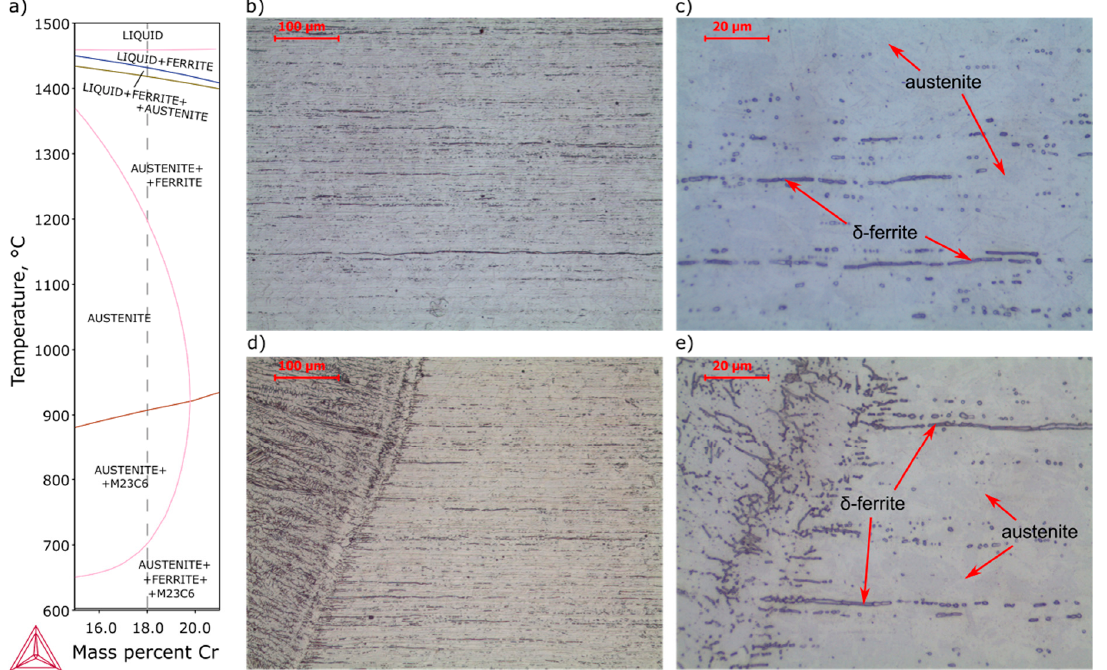
Figure 10. Microstructure of AISI 304 (X5CrNi18-10) steel heat-affected zone: ( a ) pseudobinary phase diagram of 0.05C-0.59Si-1.95Mn-0.009P-0.003S-0.04Mo-8.02Ni-0.05Cu steel, ( b ), ( c ) base metal, ( d ), ( e ) heat-affected zone (Kalling’s + CrO 3 etched).